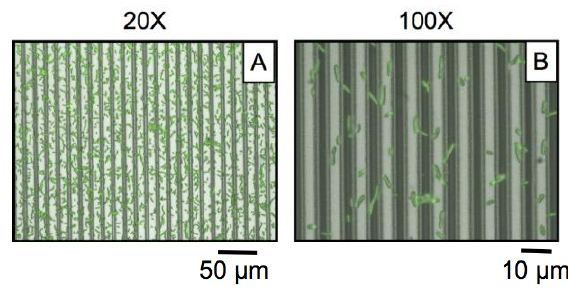
Figure A2. Image processing procedure for measuring microbial aggregate sizes on surfaces containing patterned PGMA- b -PVDMA films. ( A ) and ( B ) 20× and 100× composite brightfield-fluorescence images of P. fluorescens microbe captured onto WGA-functionalized PGMA- b -PVDMA line arrays. ( C ) and ( D ) Fluorescence images of microbes only. ( E ) and ( F ) Binary images of microbes after image processing. ( G ) and ( H ) Particle outlines for measurement of aggregate size and